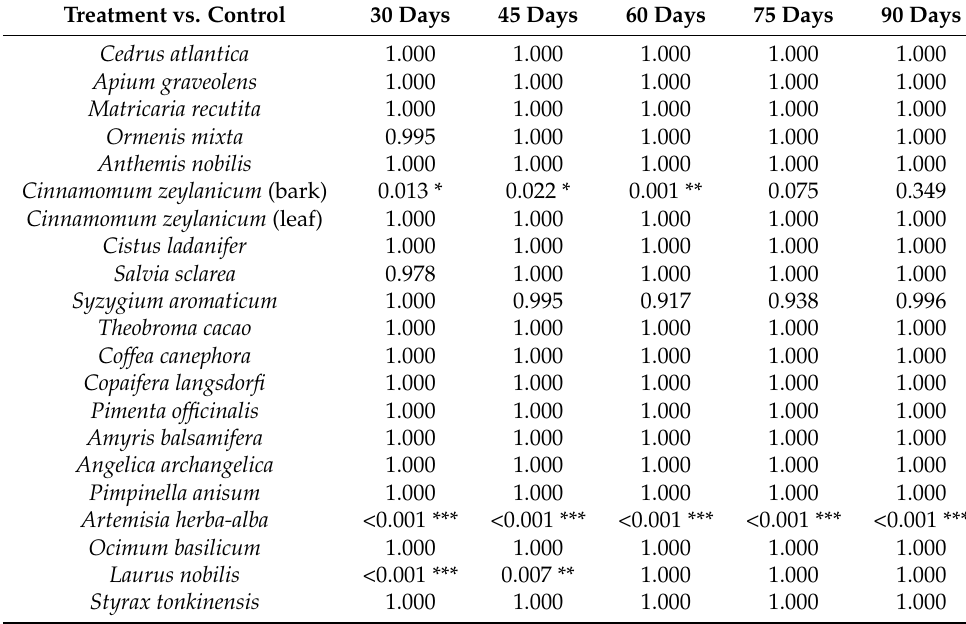
Table 5. Tukey’s test p -values describing the Eos’ effects on sprout number relative to the control at all time